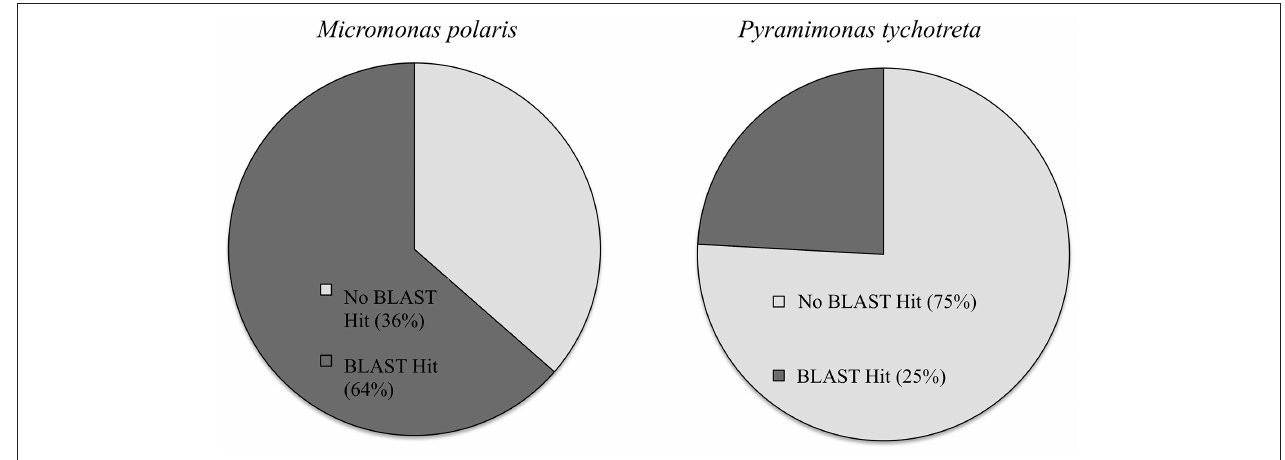
FIGURE 1 | Percentage of transcripts with BLAST matches in Uniprot database in Micromonas polaris and Pyramimonas tychotreta .